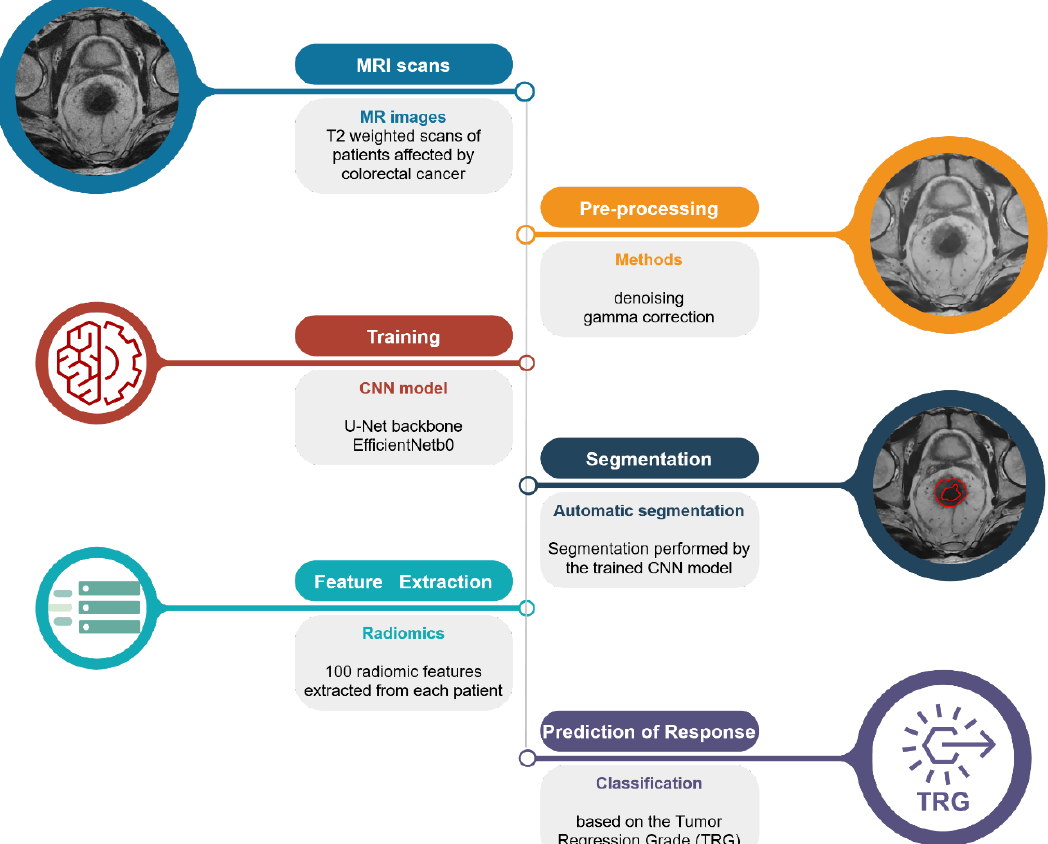
Figure 1. Schematic representation of the proposed pipeline. From the top left: raw T 2 -weighted MRI scan; pre-processed image using denoising algorithm and gamma correction for the remotion of possible confounders; segmentation of the lesion areas using the authors’ CNN model; extraction of the radiomic features from the areas identified by the CNN model; and prediction of the TRG score.